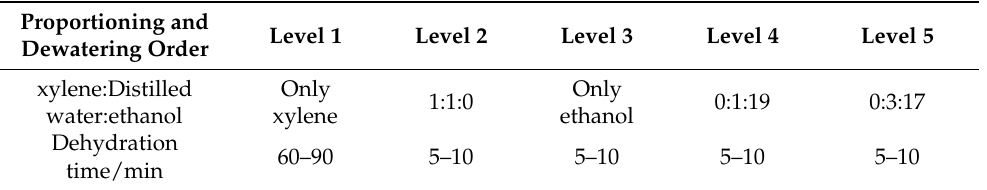
Table 2. The specific ratios of concentration grades used for dewaxing and rehydration of paraffin sections of Bougainvillea